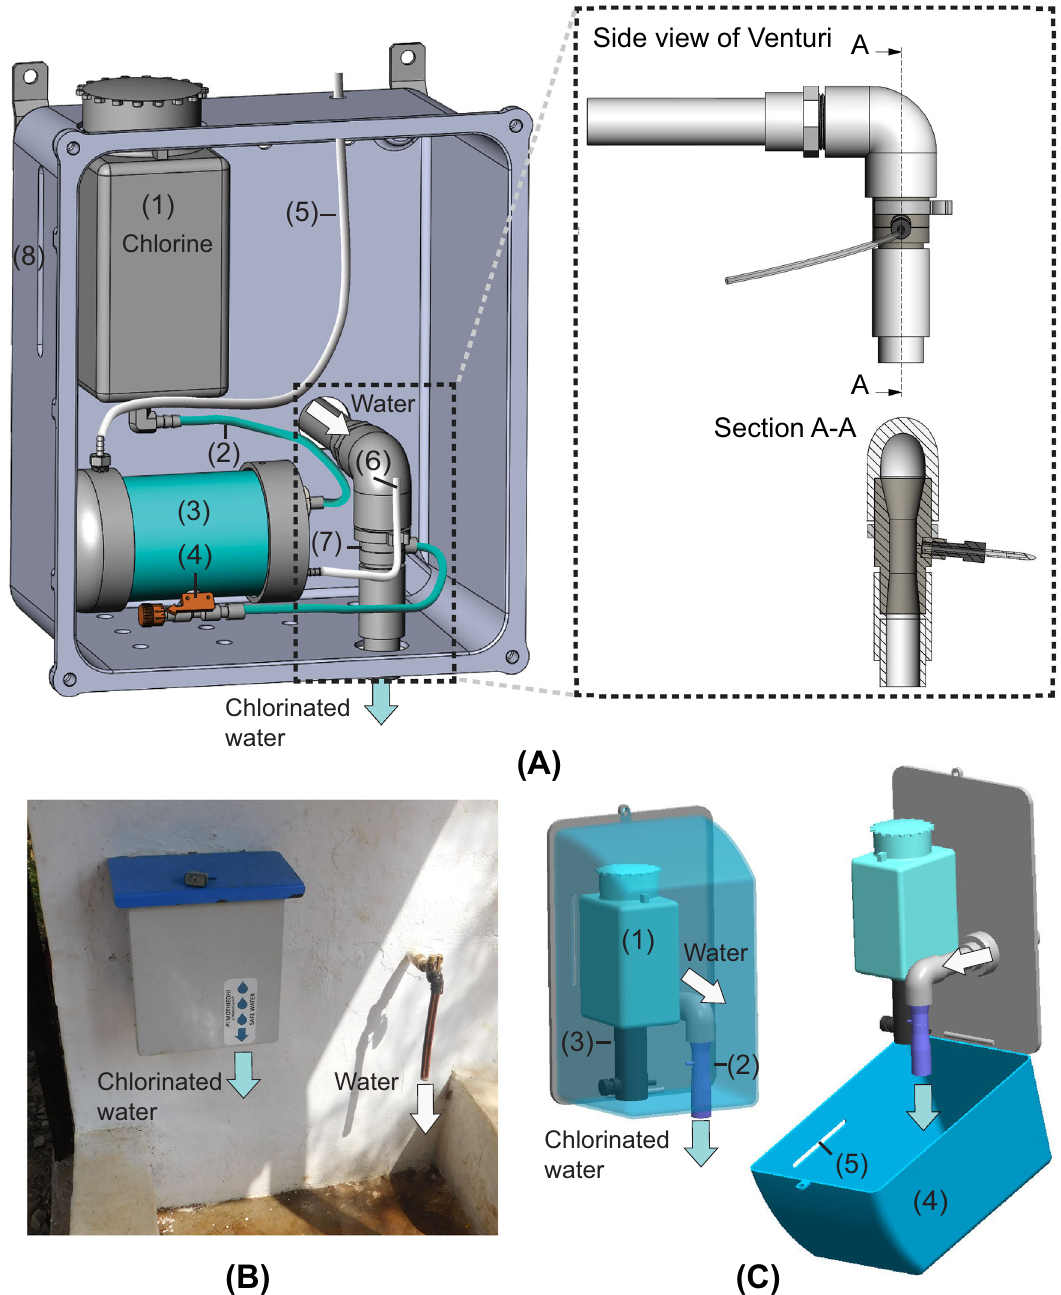
Fig. 1 Novel in-line chlorine doser (Stanford-MSR Venturi). A Schematic cross-section of Venturi. The device consists of (1) 1-L chlorine storage tank; (2) source pinch valve; (3) fl oat tank; (4) needle valve for dose adjustment; (5) vent pinch valve; (6) sight tube; and (7) Venturi. Chlorine fl ows from the chlorine tank (1) into the fl oat tank (3) when the source pinch valve (2) is open. A fl oat valve maintains the level of chlorine in the fl oat tank. The sight tube (6) may be used to adjust the fl oat tank level to just below the chlorine injection height. The needle valve (4) determines a precise amount of chlorine fl owing toward the Venturi (7) and may be adjusted. Differential pressure caused by the fl ow of water through the Venturi (7) pulls chlorine into the water stream. A window (8) allows operators to easily see the level of chlorine available in the chlorine storage tank. B Venturi installed at water kiosk in Kisumu, Kenya. Left tap provides water chlorinated with the Venturi and right tap provides unchlorinated water. C Concept for future molded Venturi. The device would consist of (1) 1-L chlorine storage tank; (2) molded Venturi; (3) fl oat valve and needle valve assembly; (4) outer cover; and (5) window to see the level of chlorine available. The estimated manufacturing cost of the molded Venturi is 34